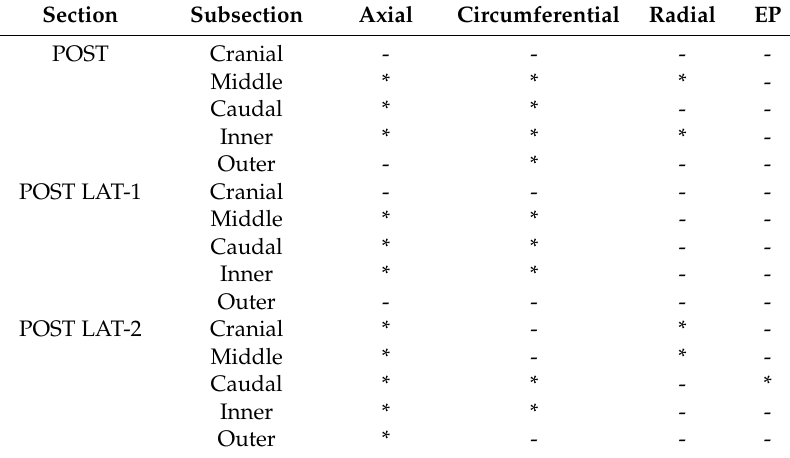
Table 4. Significance of the state of stress in predicting the damaging of the IVD in different locations. The stress responsible for the EPJFs was calculated only for POST-LAT2 ( p -values < 0.05 are marked with *).